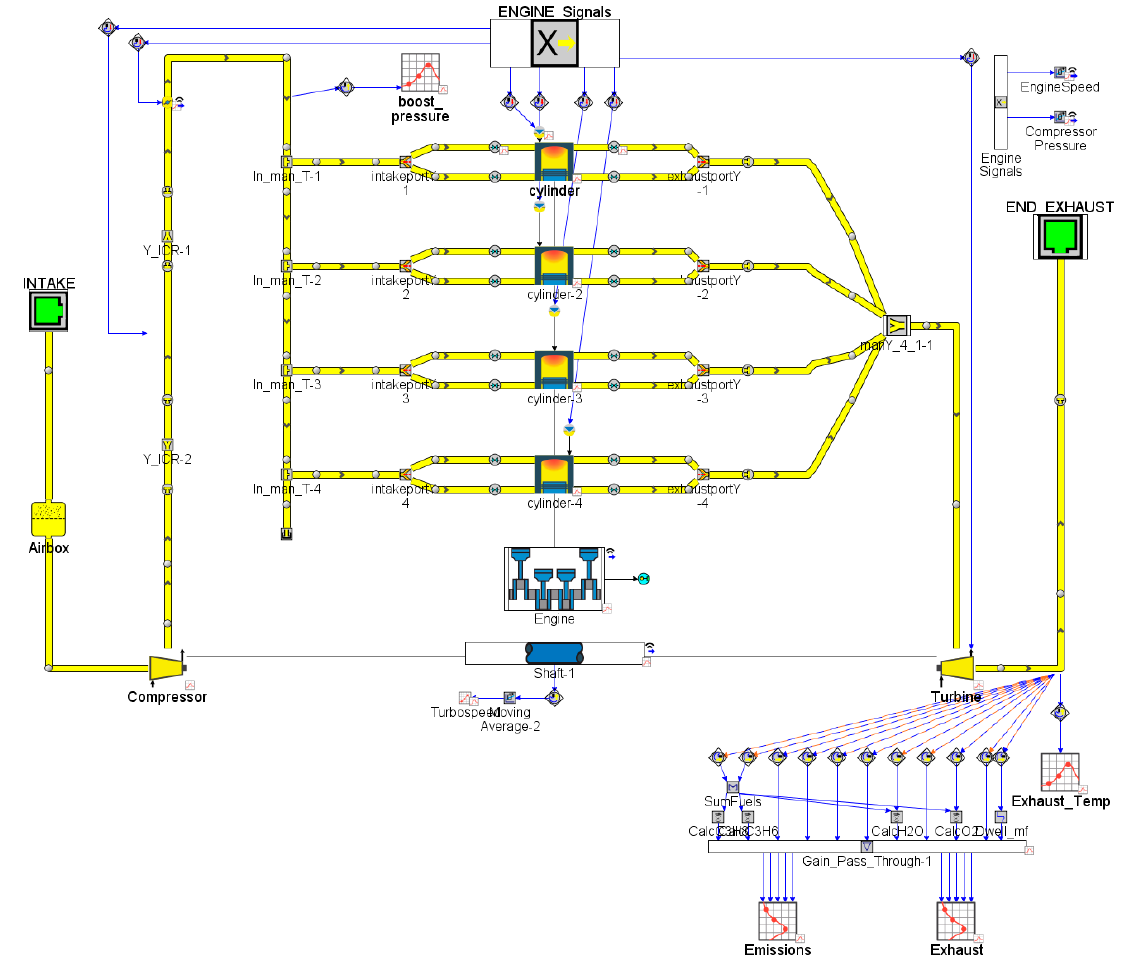
Figure 1. Engine model.